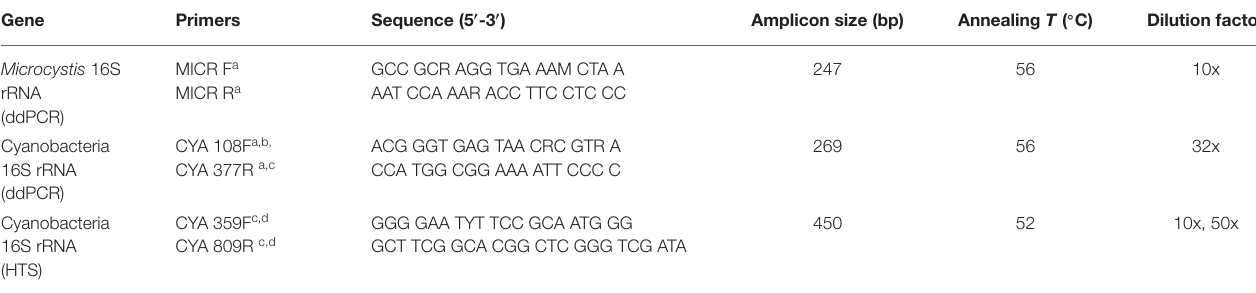
TABLE 1 | The primer sequences used in droplet digital PCR (ddPCR) and high-throughput sequencing (HTS), amplicon sizes, annealing temperatures, and dilution factors of target genes cyanobacterial 16S rRNA and Microcystis 16S rRNA. Gene